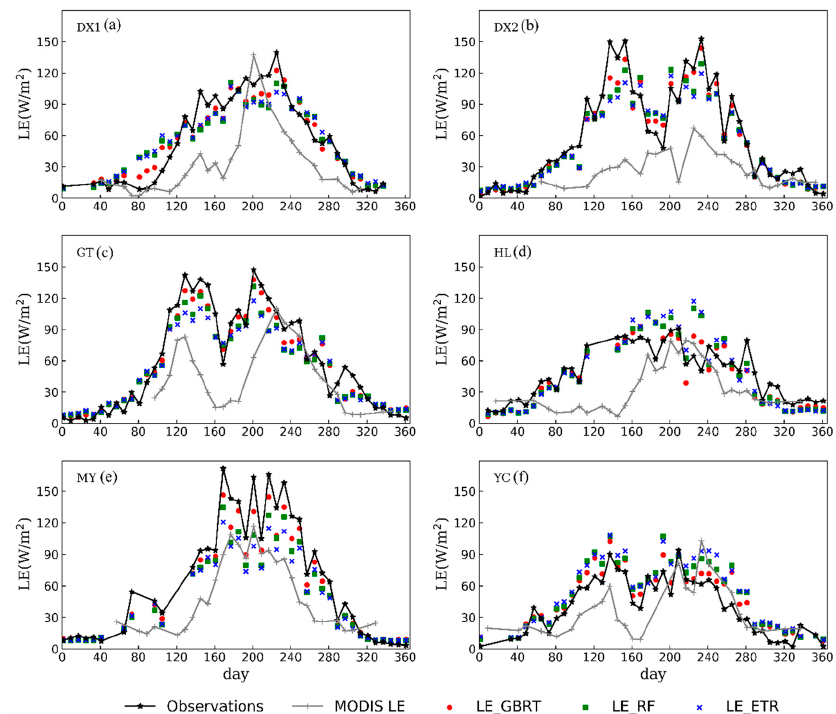
Figure 8. Examples of the eight-day terrestrial LE average as measured and estimated using different machine-learning algorithms for the different sites. ( a ): DX1; ( b ): DX2;( c ): GT; ( d ): HL; ( e ): MY; ( f ): YC.